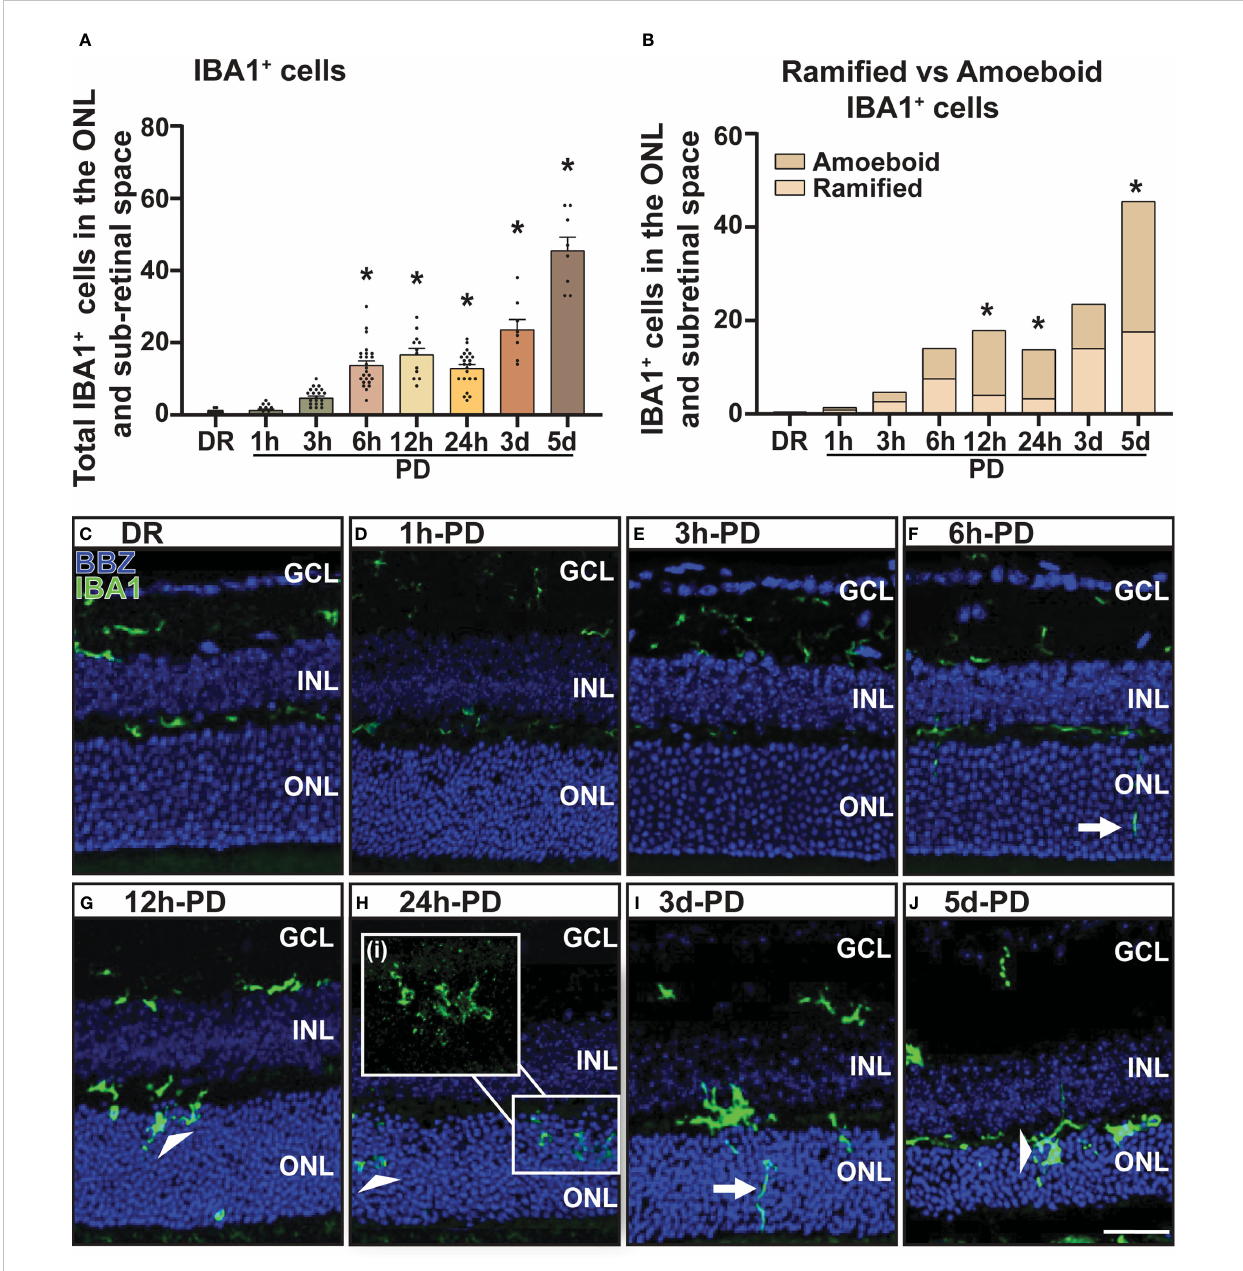
FIGURE 2 Increased presence and activation of IBA1 + microglia/macrophages in the outer retina from 6h-PD. IBA1 labelling was used to indicate microglia and macrophage recruitment to the outer retina (ONL and subretinal space). (A) IBA1 + cells were found to progressively increase in the outer retina from 6h-PD to 5d-PD compared to DR control. (B) In addition, a signi fi cantly greater number of amoeboid (activated; white arrow head) compared to rami fi ed (resting; white arrows) IBA1 + cells was found at 12h-PD, 24h-PD and 5d-PD. (C – J) Representative confocal images show increased presence and activation of IBA1 + microglia/macrophages from 12h-PD to 5dPD compared to DR controls. *Signi fi cance using a one-way ANOVA, p < 0.05 and error bars indicate SEM. Scale bar = 50 m M. n = 12. Ganglion Cell Layer (GCL), Inner Nuclear Layer (INL), Outer Nuclear Layer